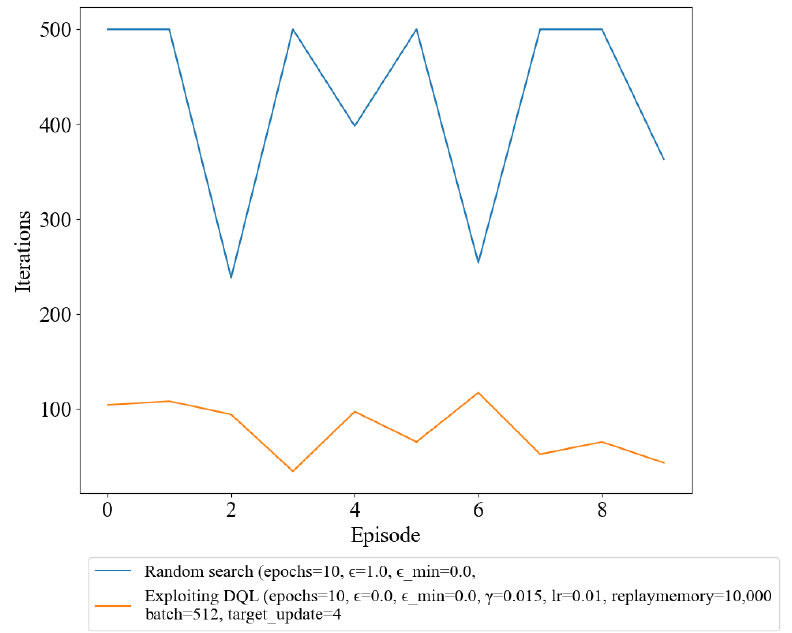
Figure 3. Number of Iterations per episode for random search and DQL. Table 2. Comparison of iteration steps to convergence between DQL and random search. Iteration Steps Policy Average Std Max Min Exploiting DQL 77.90 28.09 117 34 Random search 425.30 101.26 500